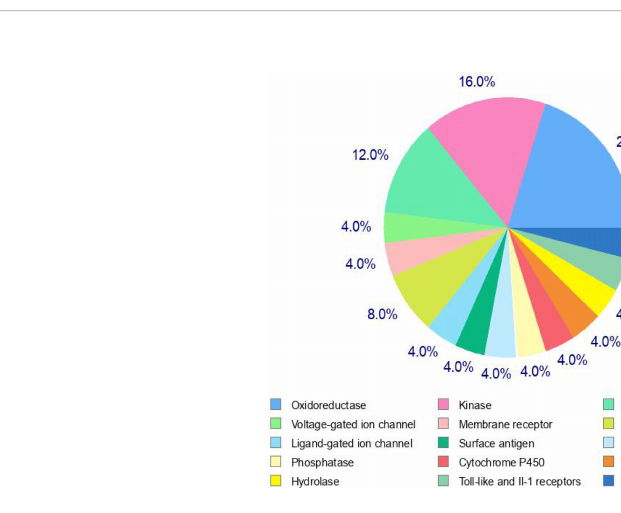
FIGURE 6 Top 25 targets predicted for xanthohumol.7